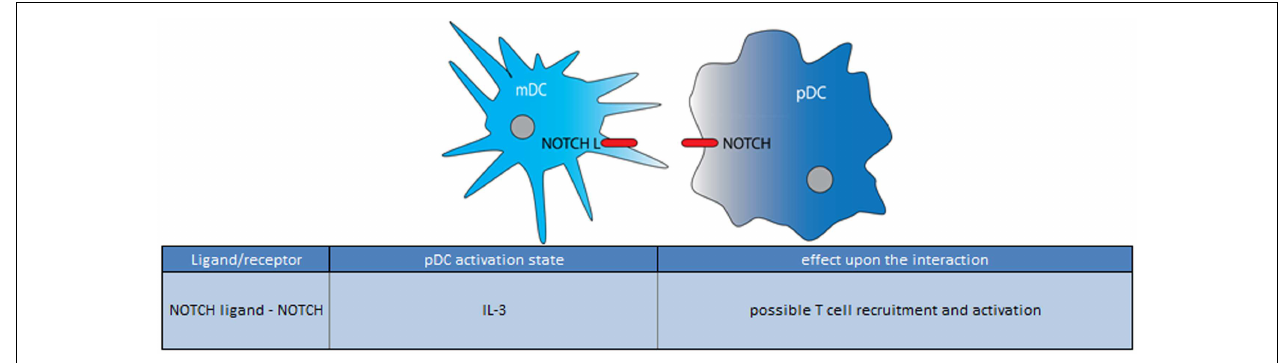
FIGURE 6 | Ligand/receptor paring of a pDC with a mDC and the maturation state/activation stimuli associated with ligand or receptor expression on the pDC surface .